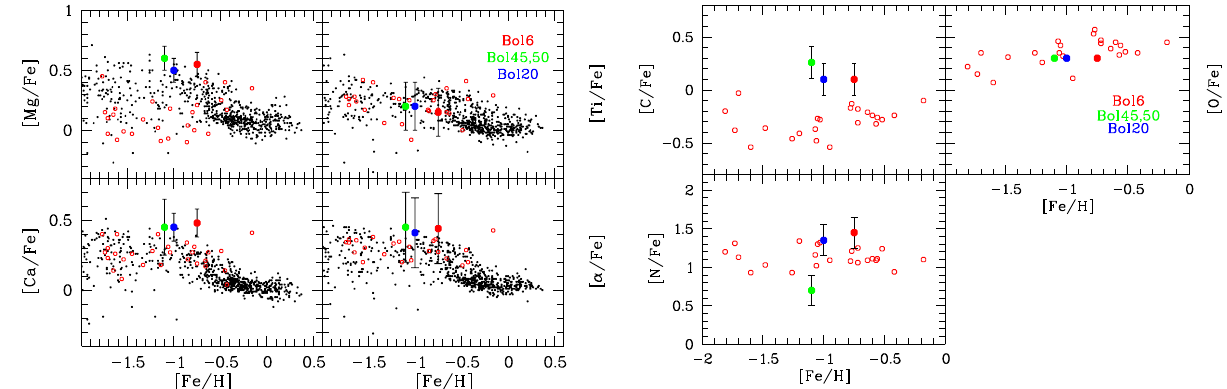
Figure 5: C, N, and O abundances measured by MMI21 for Bol 6, Bol 20, Bol 45, and Bol 50 ( fi lled circles ) in comparison with that of GCs in M31 estimated by S16.